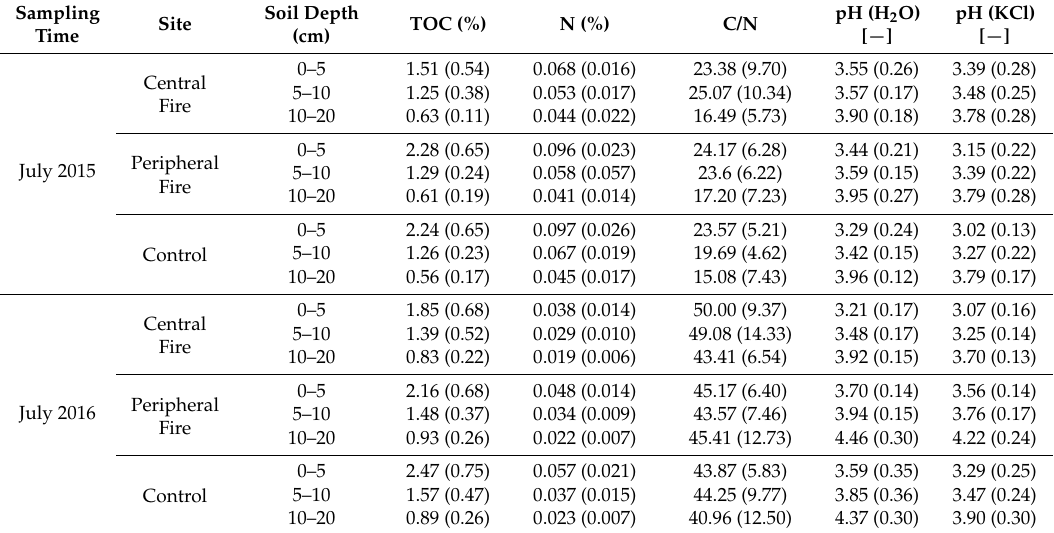
Table 1. Selected properties of soil, mean values ( n = 11) with SD in brackets. TOC—total organic carbon, N—nitrogen,